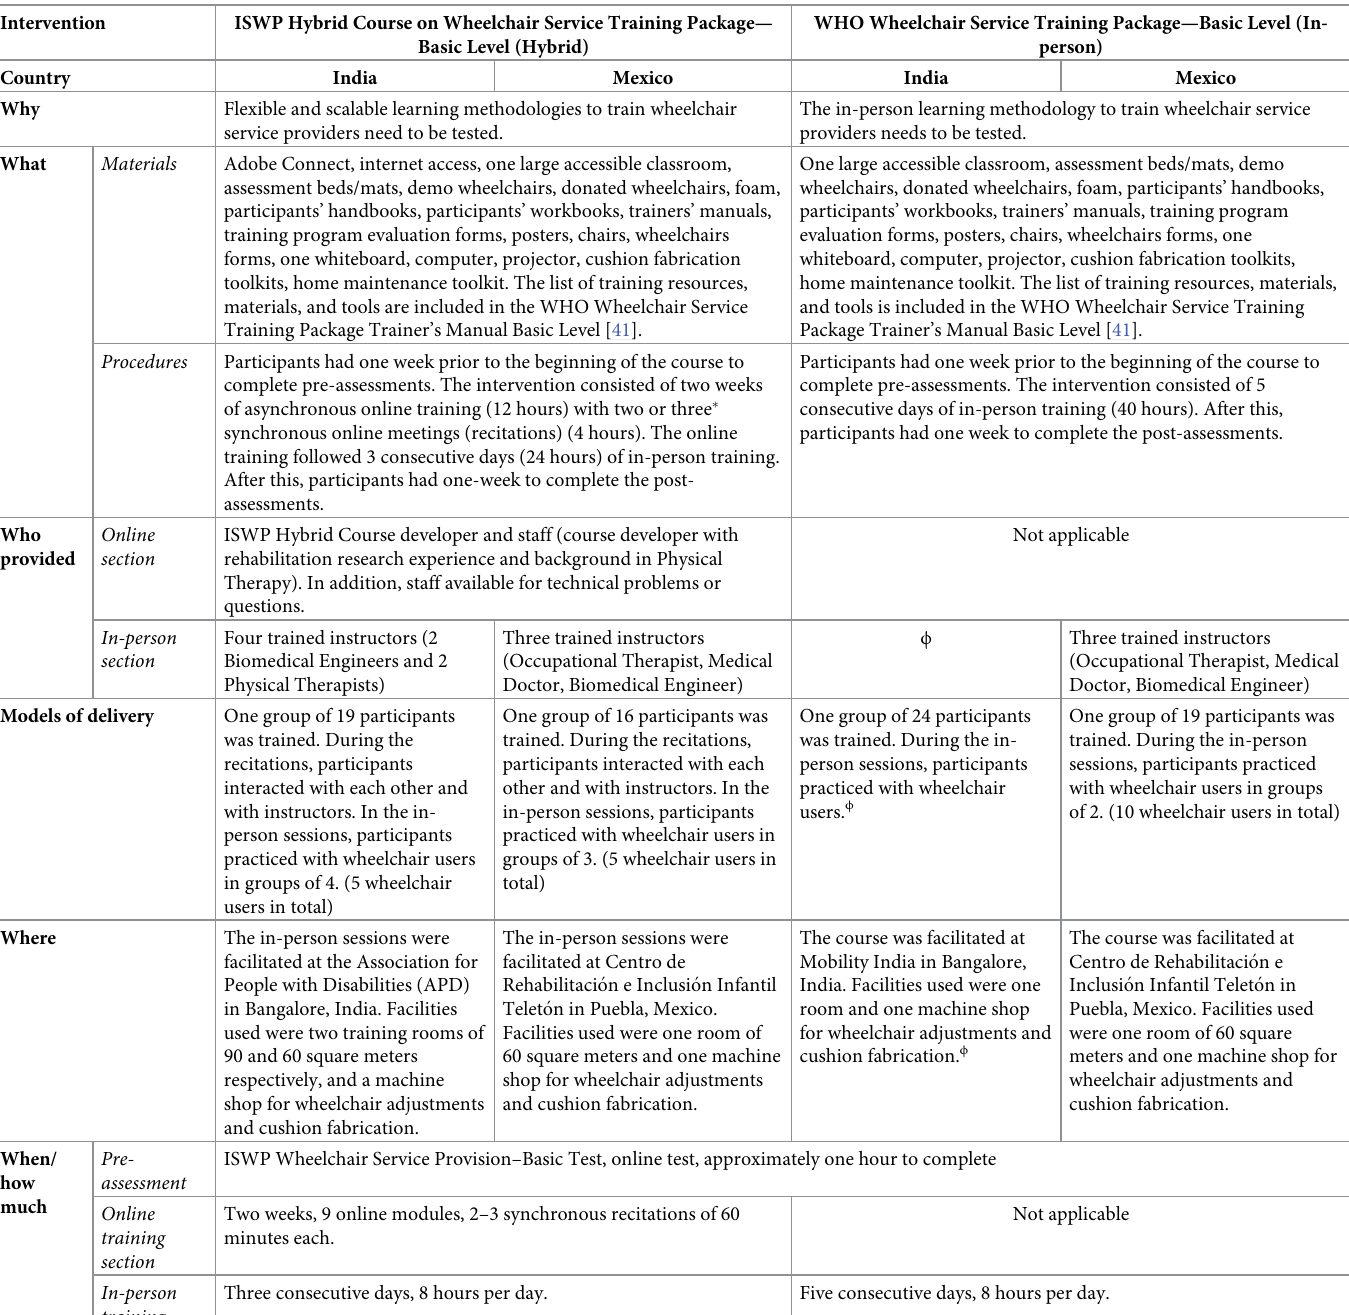
WHO Wheelchair Service Training Package—Basic Level (In- person)